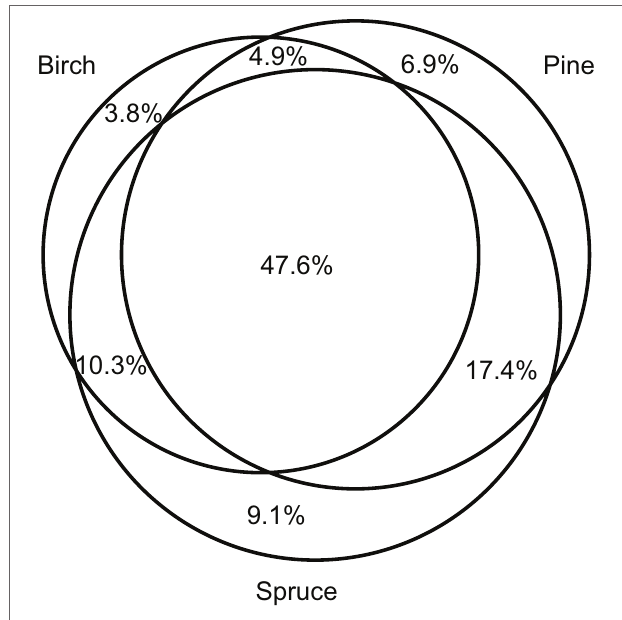
FIGURE 2 | A Venn diagram displaying the proportion of EcM fungal operational taxonomic units (OTUs) shared among Betula pendula , Pinus sylvestris , and Picea abies